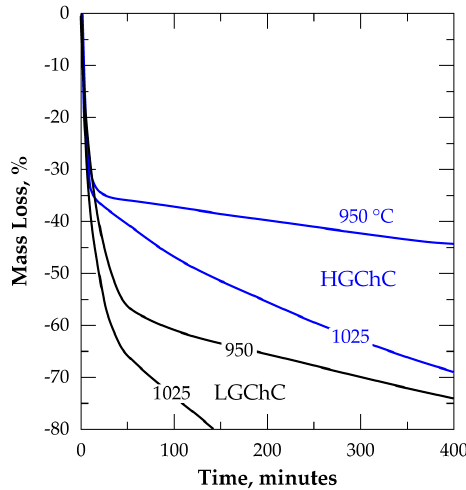
Figure 13. Comparison of the isothermal data for LGChC and HGChC treatment at 950 and 1025 °C under chlorine in presence of oxygen.